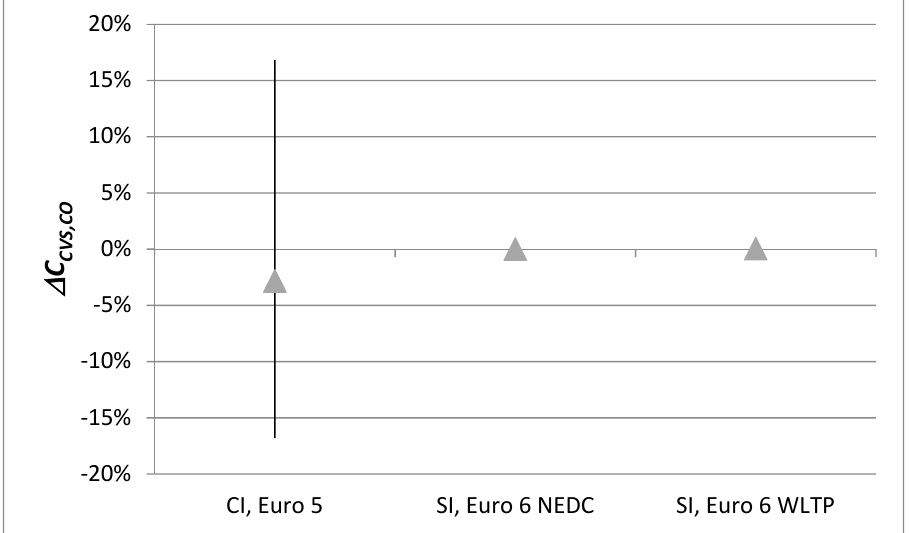
Figure 12. Relative percentage difference in determining the C CVS,corr concentration of the pollutant as calculated from dilution ratio DR (19) and dilution factor DF (3) for CO.